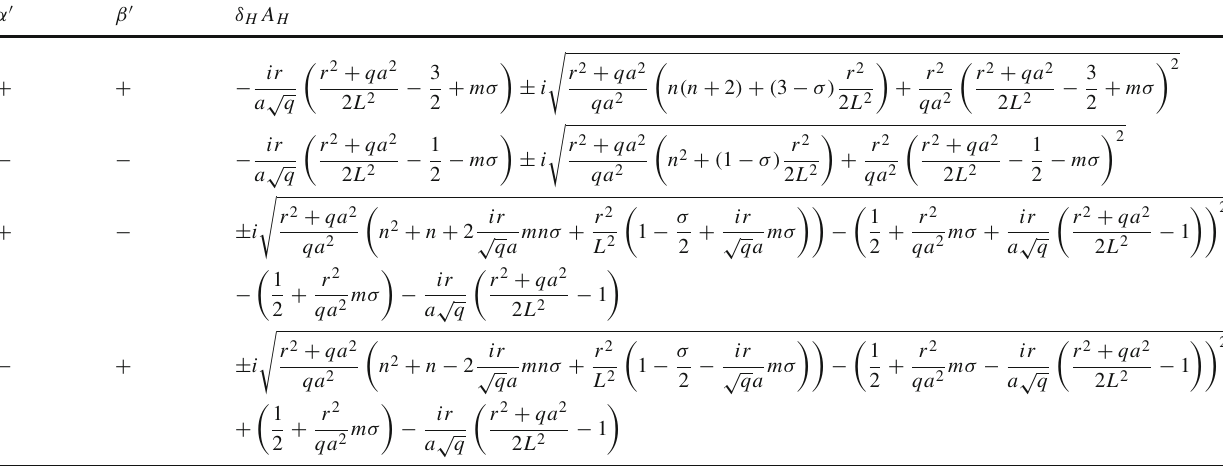
Table 3 The asymptotic parameter δ H expressed in product with A H at u H for constant field